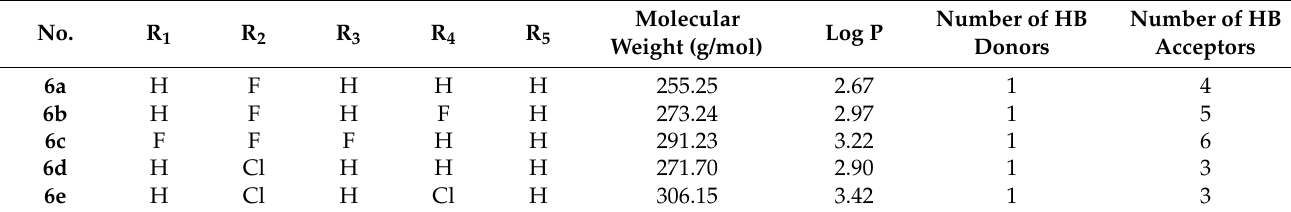
Table 1. Computed drug-like PC properties of compounds 6a – e based on Lipinski’s Rule of Five. No.